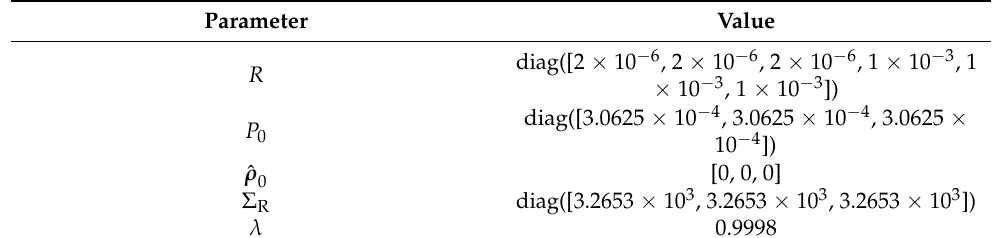
Figure 9. Measurements during a figure eight manoeuvre. The ground-truth angular rates ( ω g x , ω g y , ω g z ) and specific forces ( f g , f g , f g ) obtained from the high-performance INS/GNSS system and transformed to the mounting position of the im , x im , y im , z automotive-grade IMU, and the bias-corrected angular rates ( ω m x , ω m y , ω m z ) and bias-corrupted specific forces ( ˜ f m ˜ f m ) supplied by the automotive-grade IMU. im , z Table 2. Parameter choice, units according to the International System of Units.